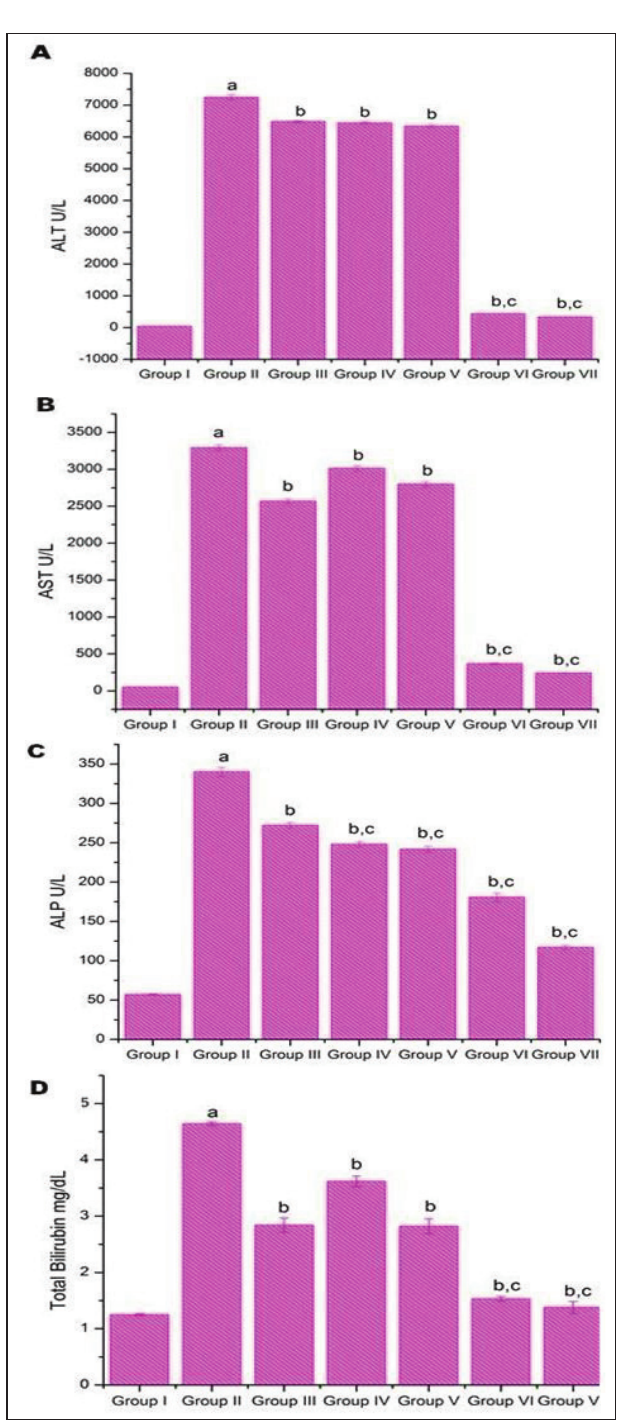
Fig-1: T. dioica protects experimental animals from CCl4-induced liver damage and significantly alters the level of serum biomarkers in treatment groups.